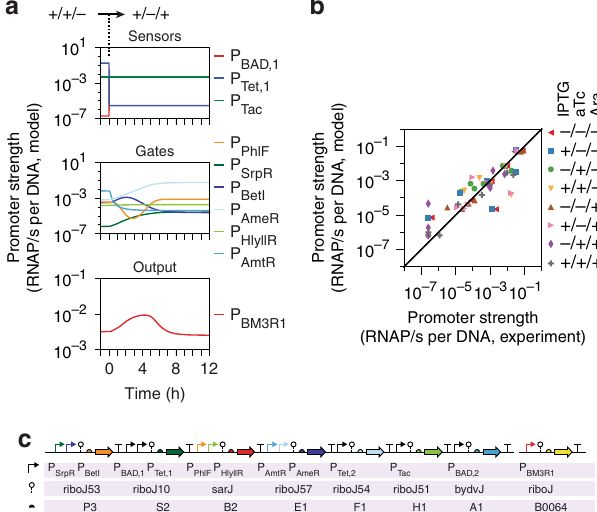
Fig. 5 Dynamic modelling of genetic circuit using – omics extracted parameters. a An example of the dynamics predicted when the circuit changes state. The differential equations used for the simulations are provided in the Methods. A t t = 0, the inputs are switched from + / + / − to + / − / + (IPTG/aTc/Ara) and the response is shown. b The predicted steady-state promoter activities of all seven gates in the circuit are compared against their measured activities across all eight induction states of the circuit (R 2 = 0.73, p value = 5.5 × 10 − 18 ). A line is drawn at x = y to guide the eye. c Sensitivity analysis. A circuit diagram showing all genetic parts used in the circuit is shown at the top. When each parameter is varied, all of the remaining parameters are held constant (Methods). Regions in pink show the parameter range that lead to circuit that no longer performs the intended logic operation (circuit score <1). The parameters of the circuit extracted from – omics data are shown as dashed lines (Tables 1 and 2). Source data are provided as a Source Data